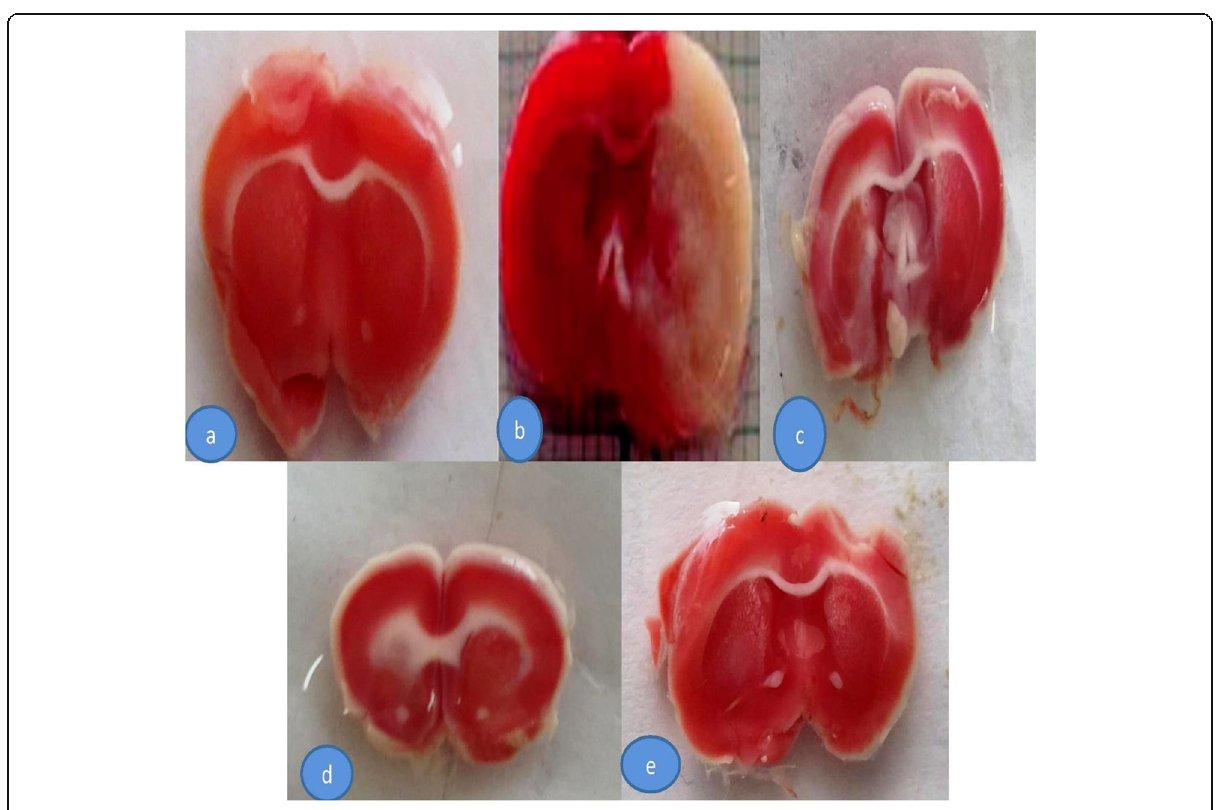
Fig. 7 Transverse sections of brain from different treatment groups stained with TTC. ( a.) Sham control (Sham) (b.) Ischemic Reperfusion group (I/ R) (c.) ( Ricinus communis Low dose) (RCLD) (d.) Ricinus communis High dose (RCHD) (e.) (Standard drug-treated group)